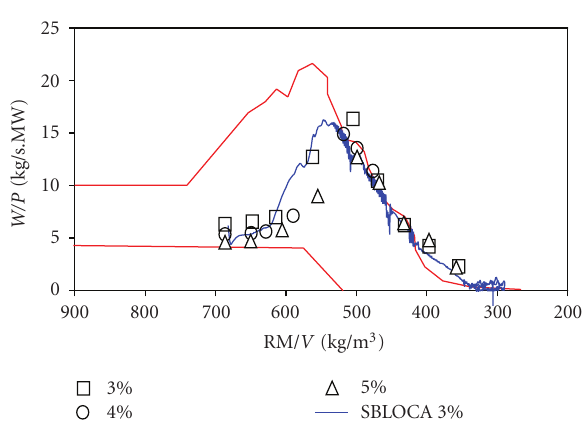
Figure 8: The natural circulation map for CNA-I PHWR NPP.